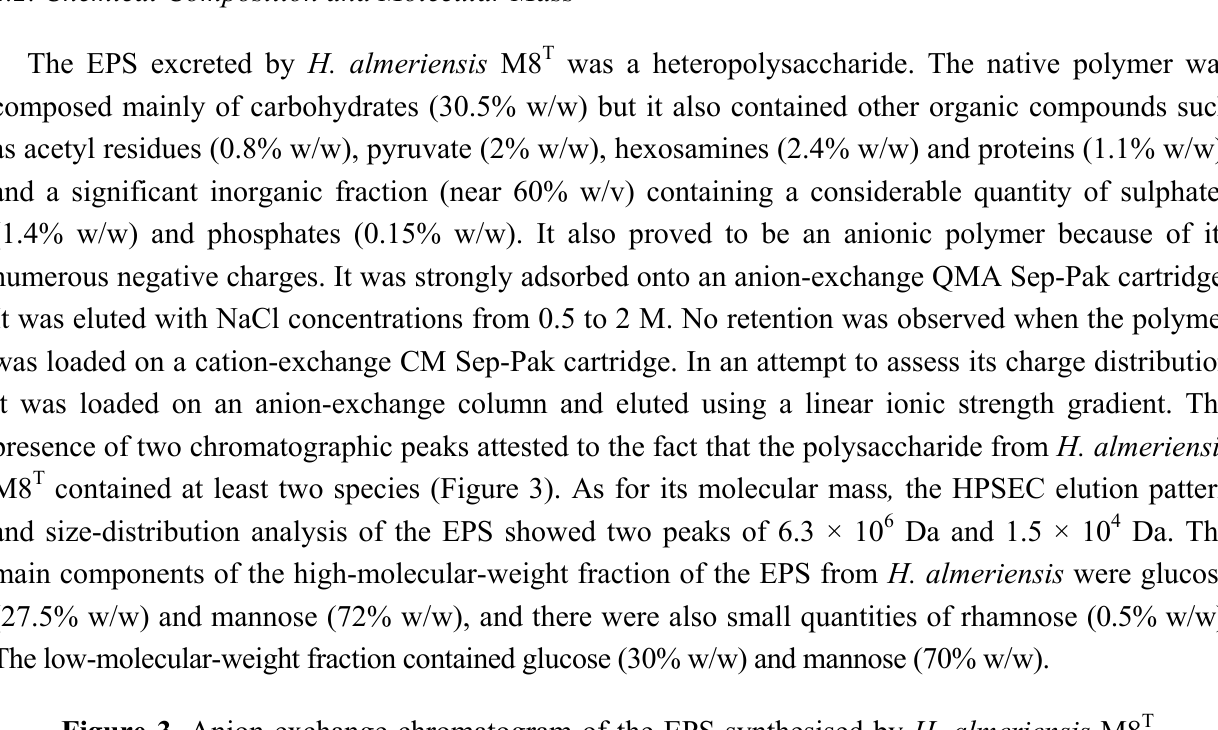
Figure 3. Anion-exchange chromatogram of the EPS synthesised by H. almeriensis M8 T . (A: 6.3 × 10 6 Daltons, B: 1.5 × 10 4